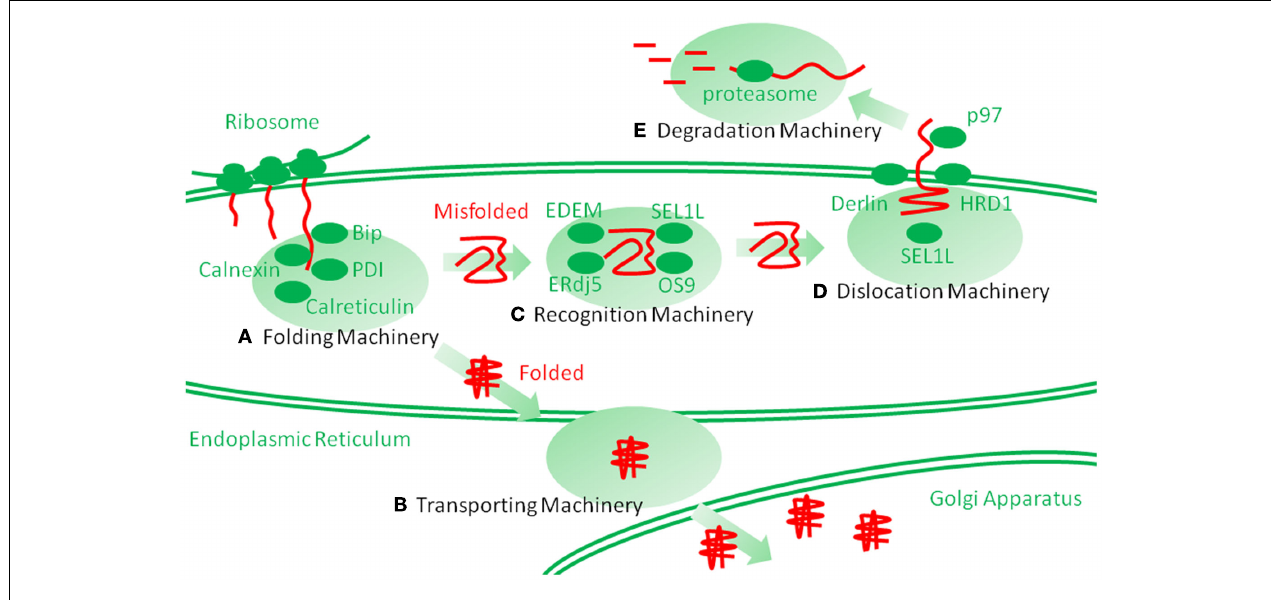
proteins that are improperly folded are specifically recognized and isolated by ERAD recognition machinery (C) , which involves ERAD-enhancing mannosidase-like protein (EDEM), ERdj5, Bip, SEL1L, osteosarcoma 9 (OS9), and XBP1.The misfolded proteins are then transferred to the dislocation machinery (D) , which involves HRD1, Derlin, Herp, and p97. Then, the proteins are dislocated into the cytosol through a putative narrow pore.The dislocated proteins are ubiquitinated by ERAD ubiquitin ligases, such as HRD1, and are finally degraded by huge cytosolic protease complexes, the proteasome (E) , into